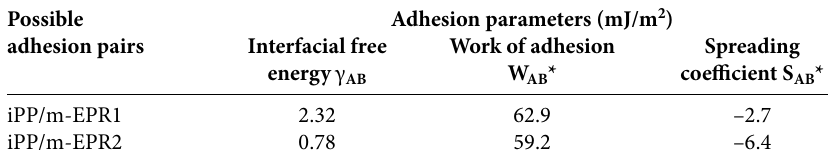
Table 5. Adhesion parameters γ AB , W AB , S AB of the iPP/m-EPR blends Possible Adhesion parameters (mJ/m 2 ) adhesion pairs